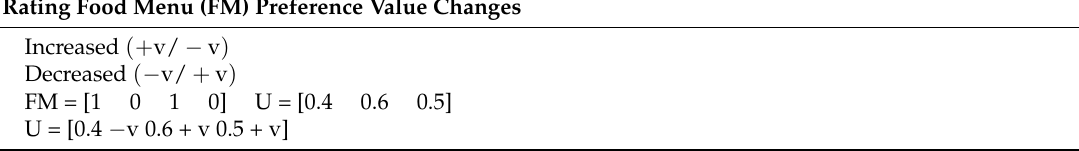
Table 3. User preference value changes.